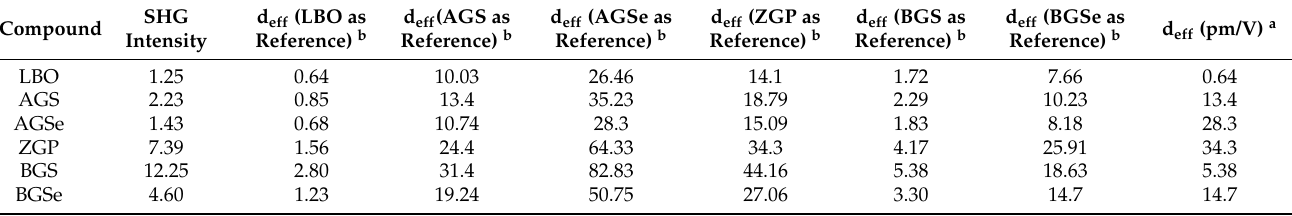
Table 2. Powder SHG intensity and the calculated SHG coefficient from different reference materials. SHG Compound